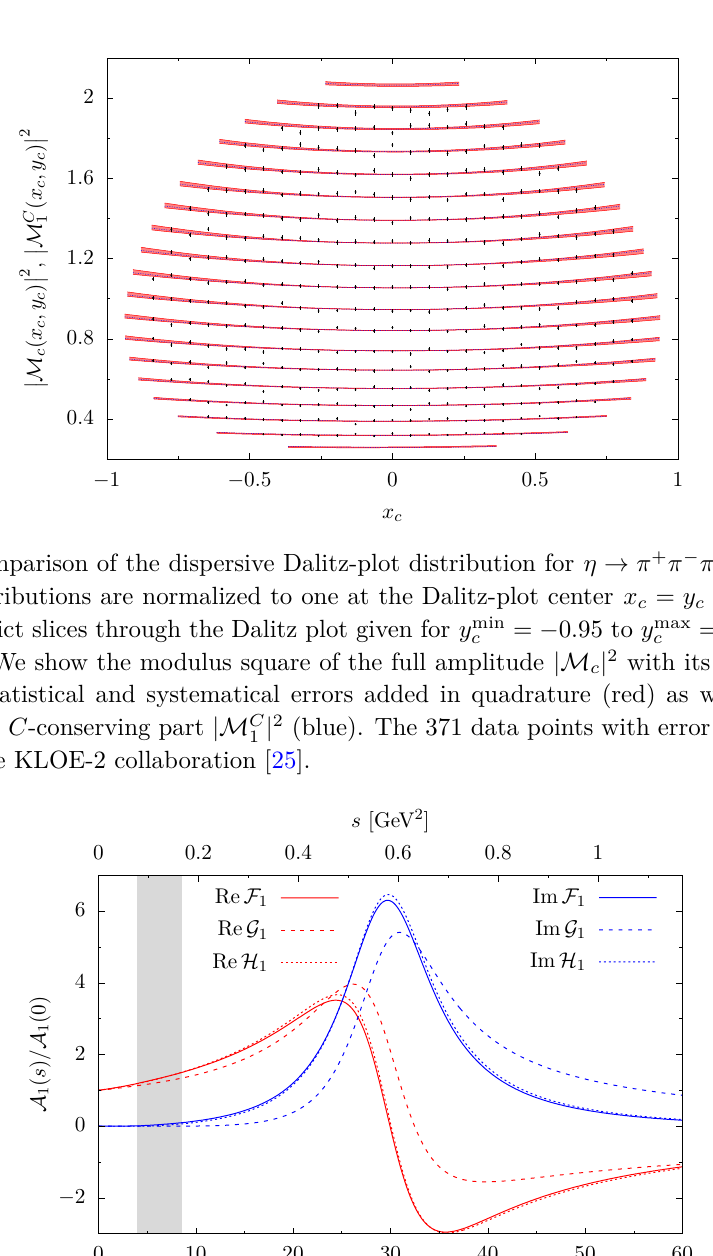
Figure 3 . P -wave single-variable amplitudes as defined in eqs. (2.21) and (2.22). Each amplitude is normalized to 1 at s = 0 and F is fixed by the central values of the respective subtraction 1 constants from table 2. The phase space for η → 3 π is indicated by the gray